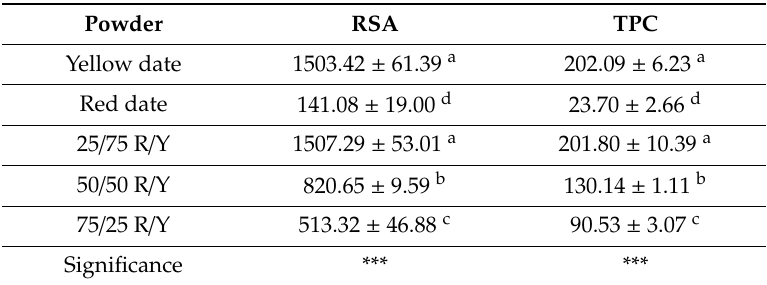
Table 3. Total phenolic content (TPC; mg GAE / g dry weight) and radical scavenging activity (RSA; µ mol eq. Trolox / g dry weight) of powder of the two Tunisian P. canariensis date varieties and mixes used for biscuit production (R-red; Y-yellow; mean ± standard error) and results of variance analysis with Duncan’s test.